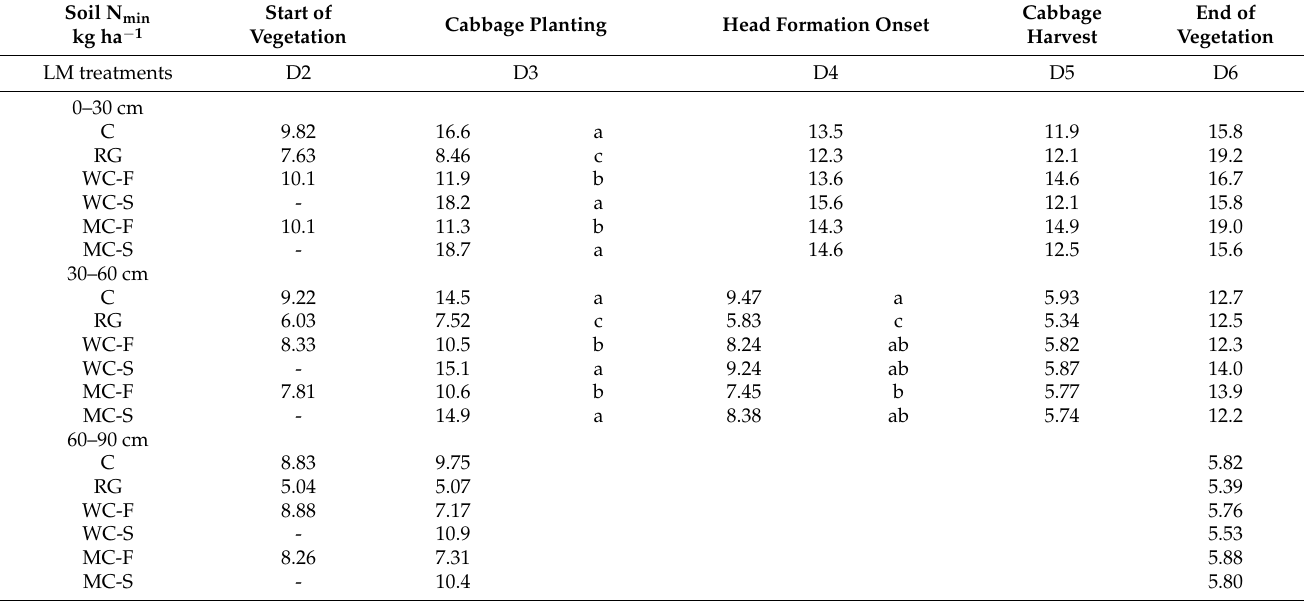
Table 4. Soil N min content during the LM and cabbage cultivation period at both locations between March and November (D2–D6) at the depths 0–30, 30–60 and 60–90 cm. Values with at least one identical letter indicate non-significant differences among growth management (capital letters) and LM treatments (lower-case letters) at α = 0.05. Values without letters were not found to be significantly different indicated via global F test.